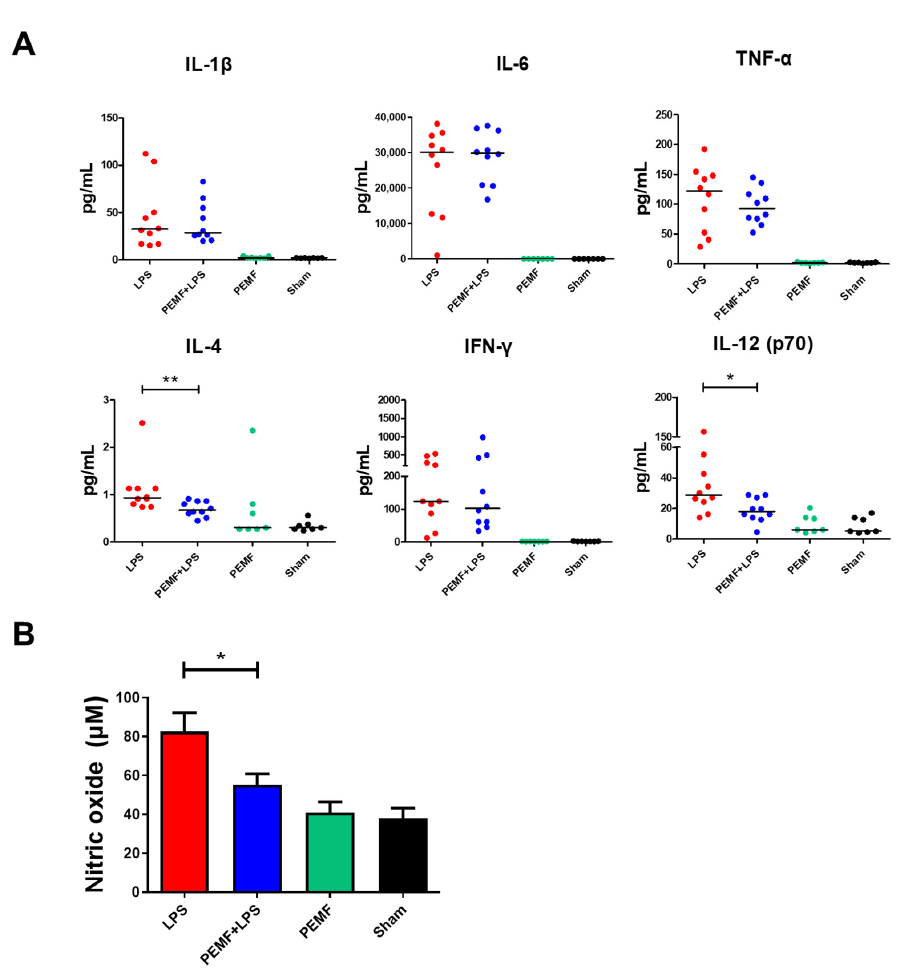
Figure 4. Effect of PEMF treatment on serum cytokines and nitric oxide of septic shock-induced mice. Mice were injected with LPS (15 mg/kg) and exposed to PEMF for 1 day. ( A ) Serum levels of cytokines IL-1 β , IL-6, TNF- α , IL-4, IFN- γ , and IL-12 (p70) were evaluated using cytometric bead array. Each dot represents one mouse. Bars indicate median. ( B ) Levels of serum nitric oxide were analyzed by Griess reagent. * p < 0.05, ** p < 0.05 (Mann–Whitney test).